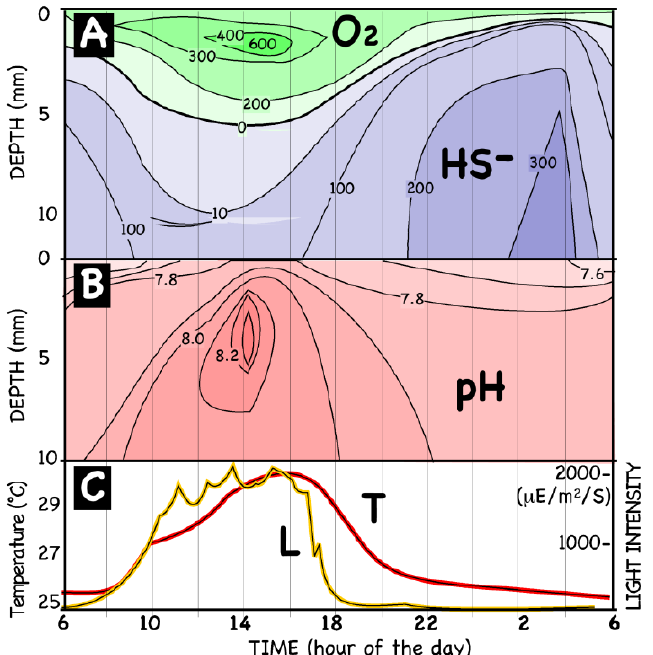
Figure 8. Oxygen and sulfide concentration (ppm) in ( A ) and pH in ( B ) variation during a diel cycle in the upper 12 mm of modern marine stromatolites in the Exuma Cays, Bahamas. ( C ): Light intensity and temperature at the surface of the stromatolite. (Adapted with permission from Ref. [65]. Copyright © 2002, American Chemical Society.).